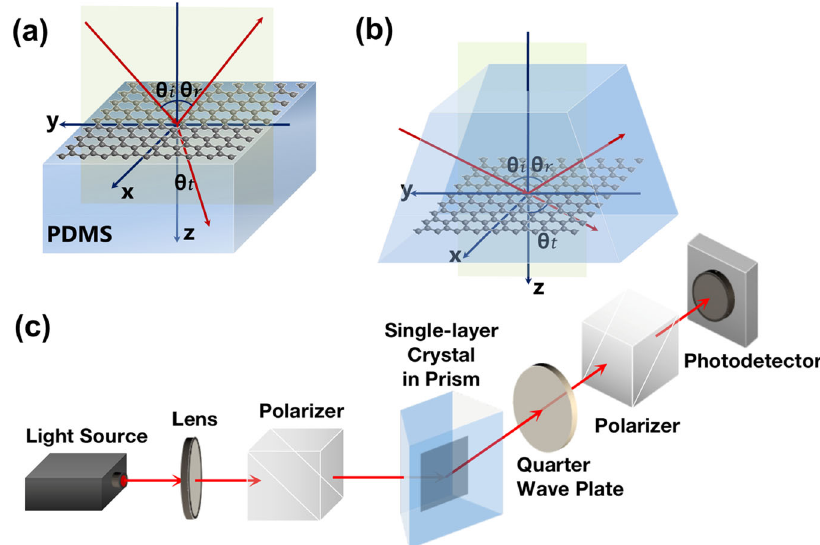
Fig. 1 Experimental set up. a First step of the experiment: standard spectroscopic ellipsometry on a single-layer 2D crystal deposited on a polydimethylsiloxane (PDMS) substrate. b Second step of the experiment: manual ellipsometric measurement on the same crystal completely immersed in a PDMS prism. c Set up of the manual ellipsometer, at the wavelength of 633